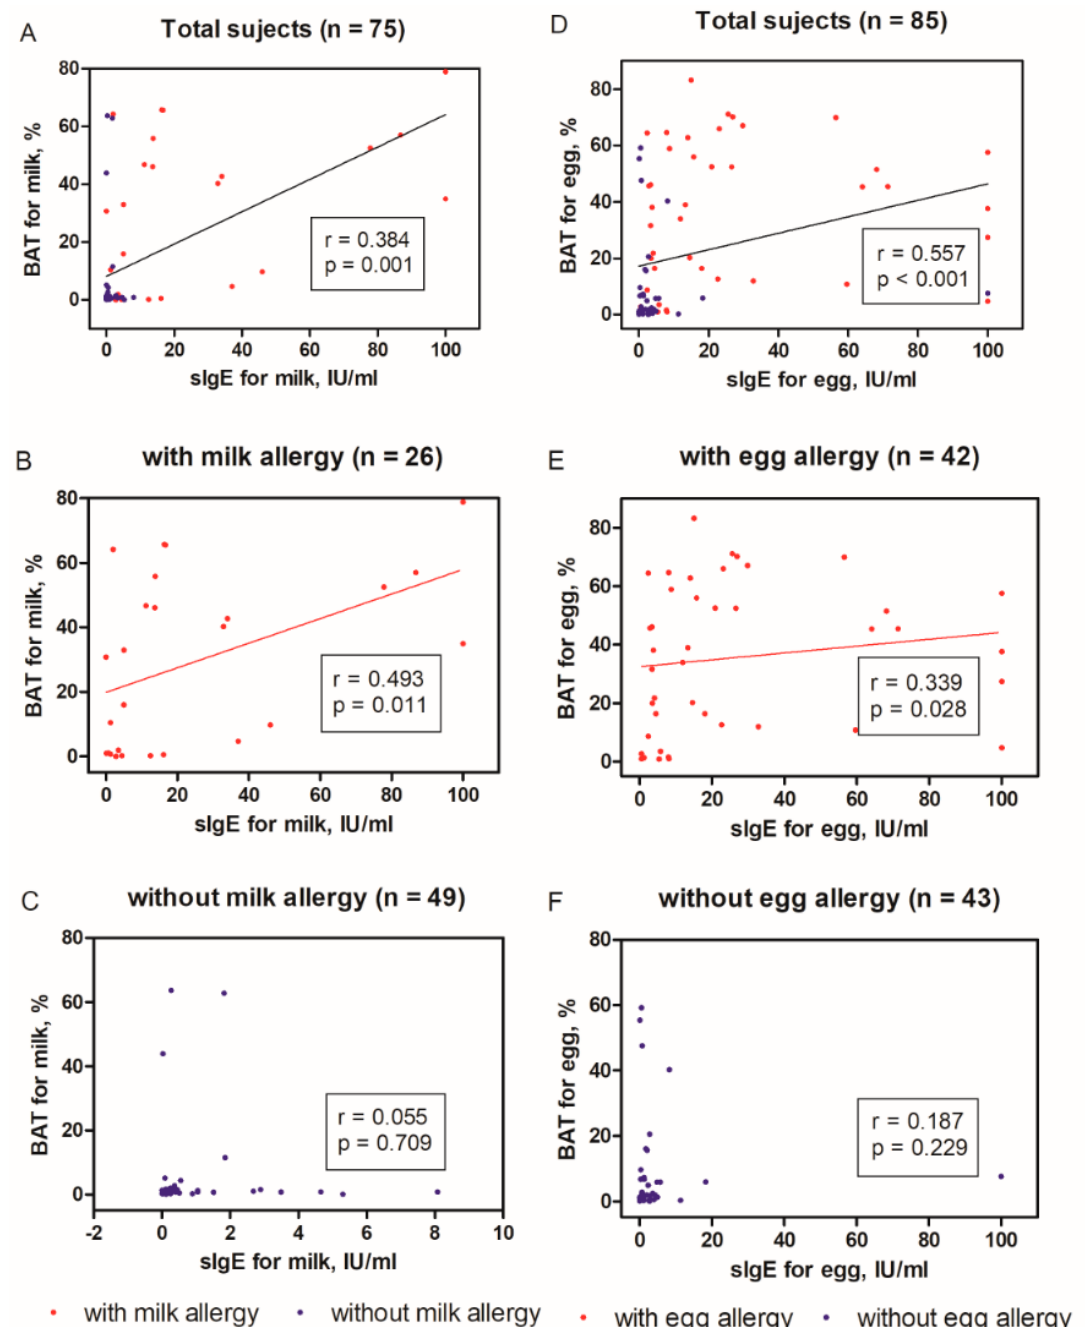
Figure 1. The overall correlation between specific immunoglobulin E (sIgE) levels and percentages of CD63+ basophils using the basophil activation test (BAT), when testing for milk (total subjects shown in ( A ), with milk allergy shown in ( B ), without milk allergy shown in ( C )) and egg allergy (total subjects shown in ( D ), with milk allergy shown in ( E ), without milk allergy shown in ( F )). r, Spearman’s correlation coefficient. sIgE, specific immunoglobulin E; BAT, basophil activation test, CD63+ basophils, basophil with the expression of CD63 .